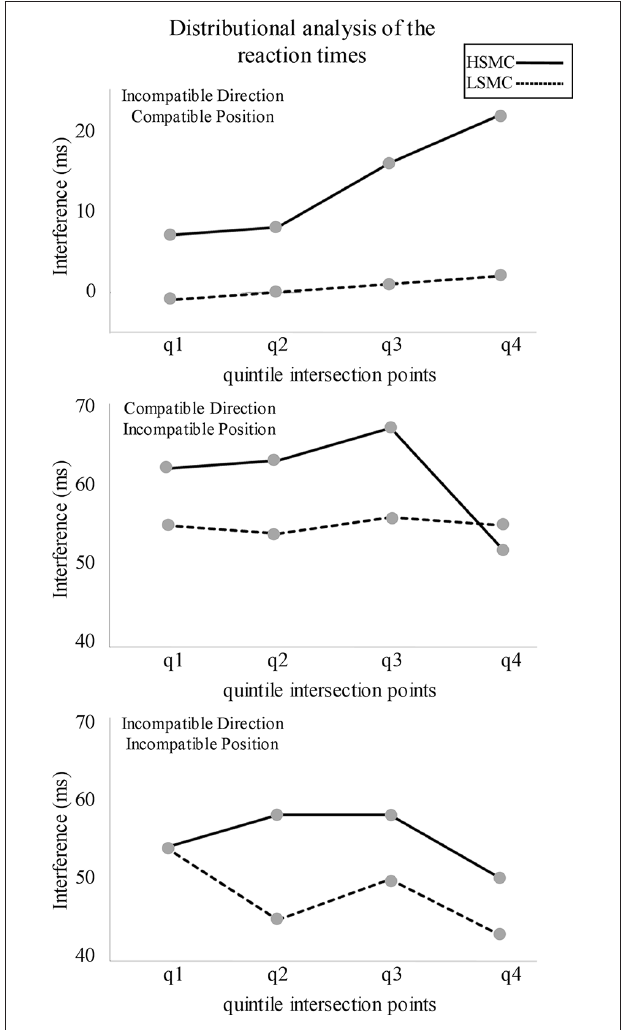
FIGURE 2 | Distributional analyses of the reaction times (RTs) in the three experimental conditions in which a spatial conflict was present. Interference from the spatial position was significant in all the quintiles for both groups. Interference from the direction pointed by the arrow was significant in q3 for the high subjective memory complaints (HSMC)